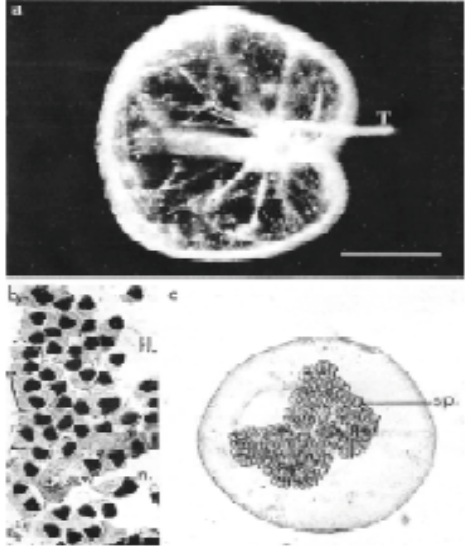
Figure 12. The heterotrophic dinoflagellate Noctiluca scientillans . ( a ). Adult trophozoite observed in vivo. x 65. Scale bar = 250 µ m. Photo using dark field microscopy by J. Lecomte, Arago Laboratory. ( b ). Spores about to be released. n. nucleus, fl. flagellum. x 1075. ( c ). Overview of the Noctiluca about to release its spores. x 65. ( a – c ). taken from [26], Reprinted/adapted with permission from Ref. [26].